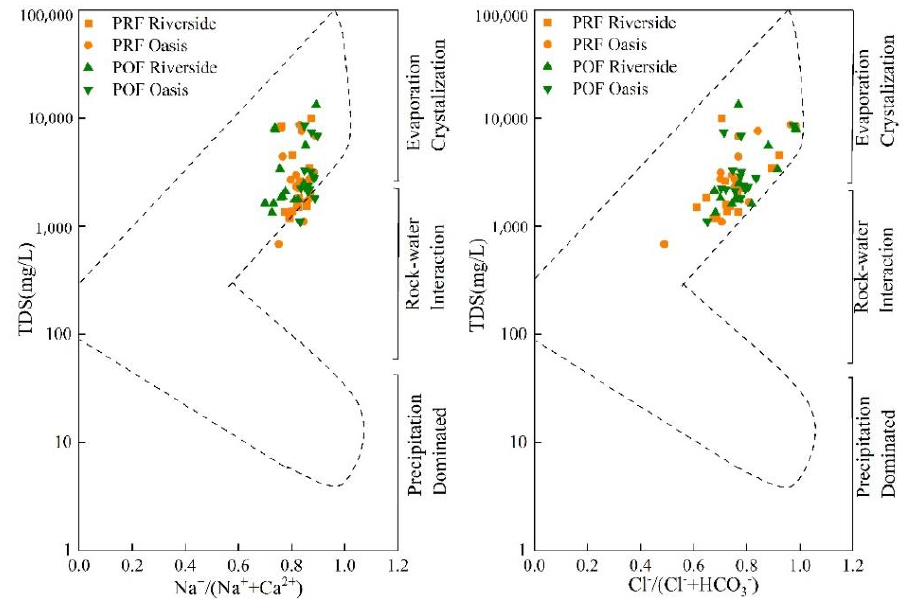
Figure 6. Gibbs diagrams signifying the control mechanism of groundwater chemistry.